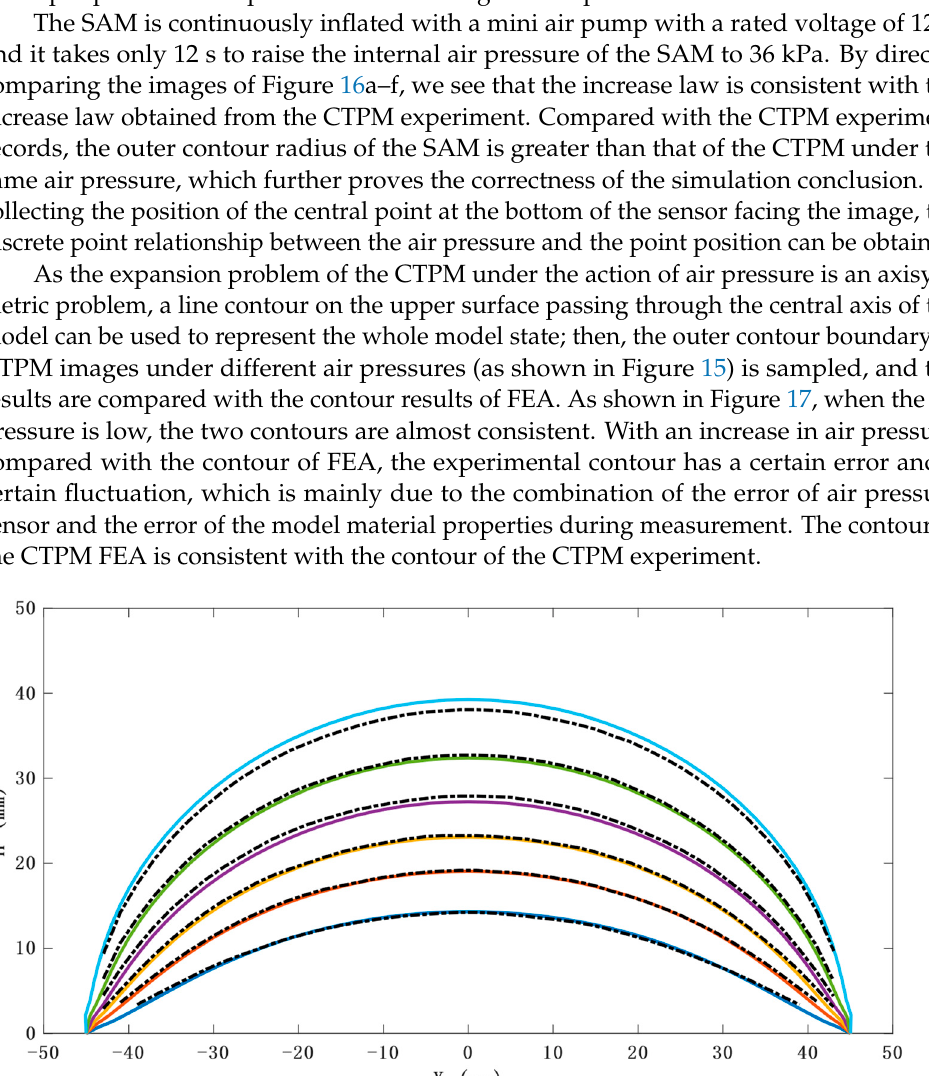
( b ) Figure 18. Relationship between CTPM and SAM center point displacement and air pressure. ( a ) Relationship between CTPM center point displacement and air pressure and ( b ) relationship be- tween SAM center point displacement and air pressure. Experimental data represent the relation- ship between center point displacement measured by the model and air pressure. FEA represents the relationship between center point displacement and air pressure based on the ABAQUS finite- element analysis. Mathematical model, which models data into Equations (5)–(8), represents the relationship between the displacement of the center point and the air pressure. The deformation of SAM can be approximately regarded as an axisymmetric prob- lem. The point displacement path of one outer ring sensor can be used to take the paths of all outer ring sensors representing SAM, change the sampling density, and derive the